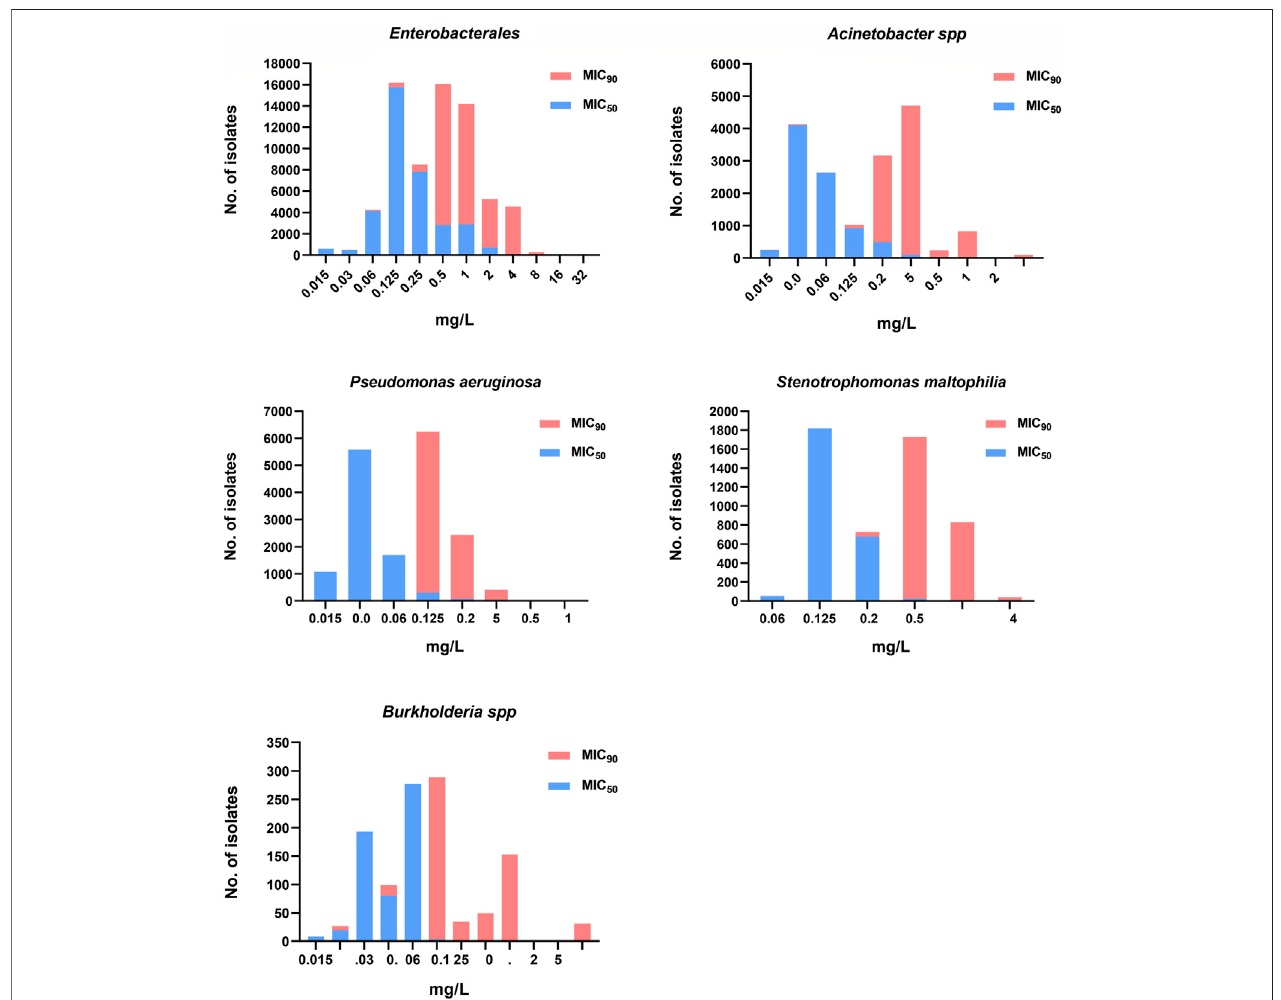
FIGURE 2 | The ce fi derocol MIC 50 and MIC 90 distribution of Enterobacterales , Acinetobacter spp , Pseudomonas aeruginosa , Stenotrophomonas maltophilia and Burkholderia spp .